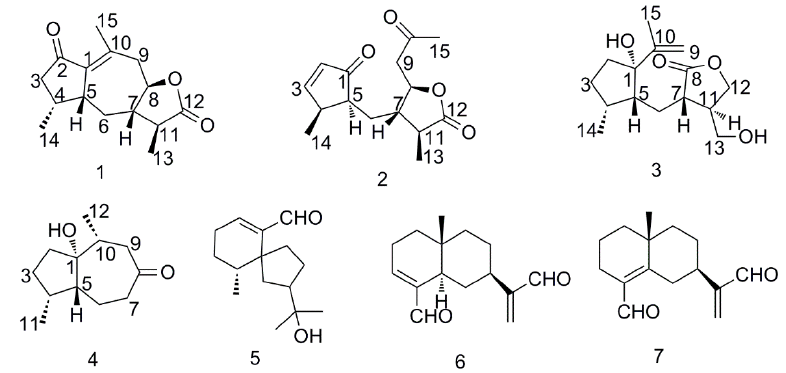
Figure 1. Structures of compounds 1 – 7 .